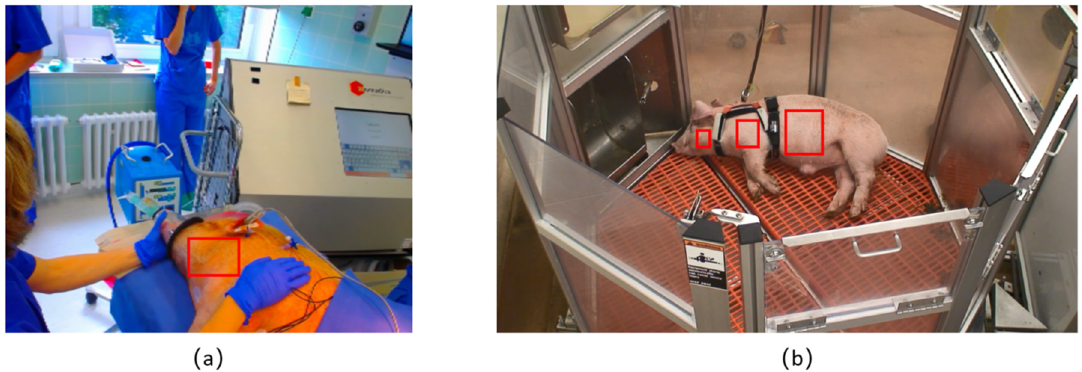
Figure 1. ( a ) Experiment set-up of the anesthetized pig; ( b ) experiment set-up of the resting pig. The red rectangles represent regions of interest chosen to investigate for heart rate monitoring.